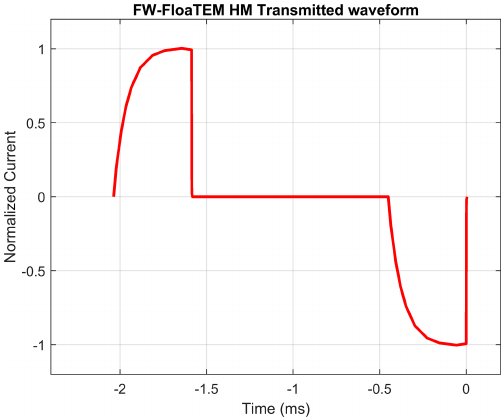
Figure A4. HM current waveform for the FW-FloaTEM system.